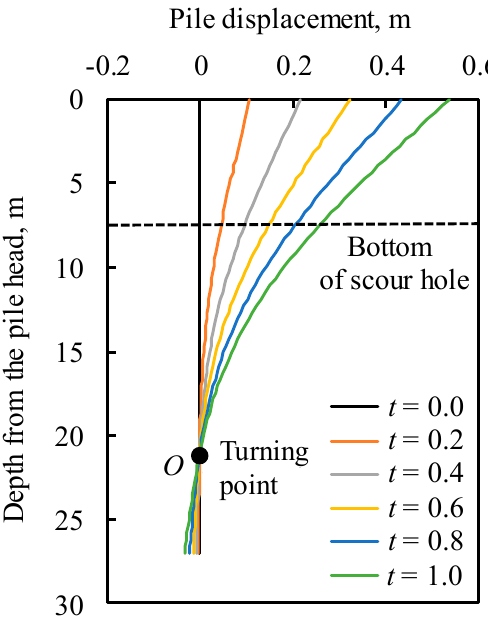
Figure 6. Displacements along the pile during the lateral Figure 6 . Displacements along the pile during the lateral loading.